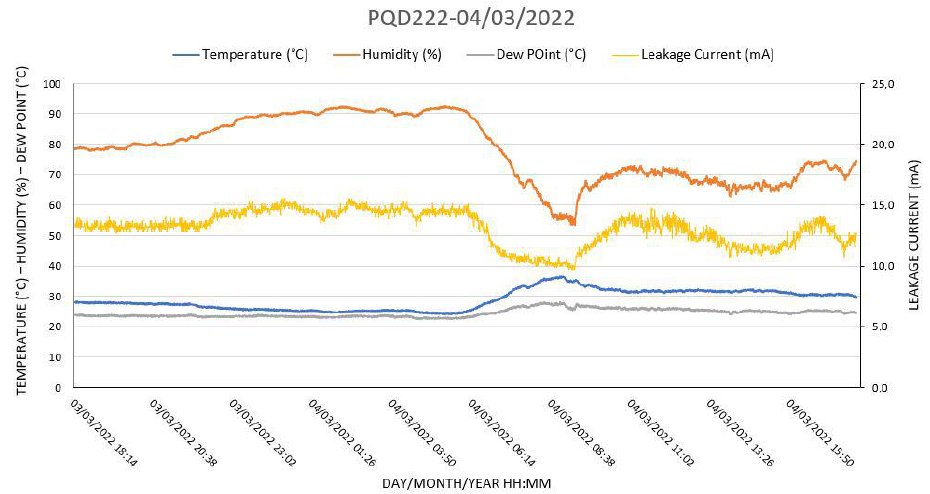
Figure 16. During the night, the humidity rose above 90%, together with a temperature drop that was close to reaching the dew point, producing a small rise of the LC to 15 mA. Note that just after dawn, the temperature rose to 38 °C and the humidity decreased to 50%, dropping the LC to 10 mA.